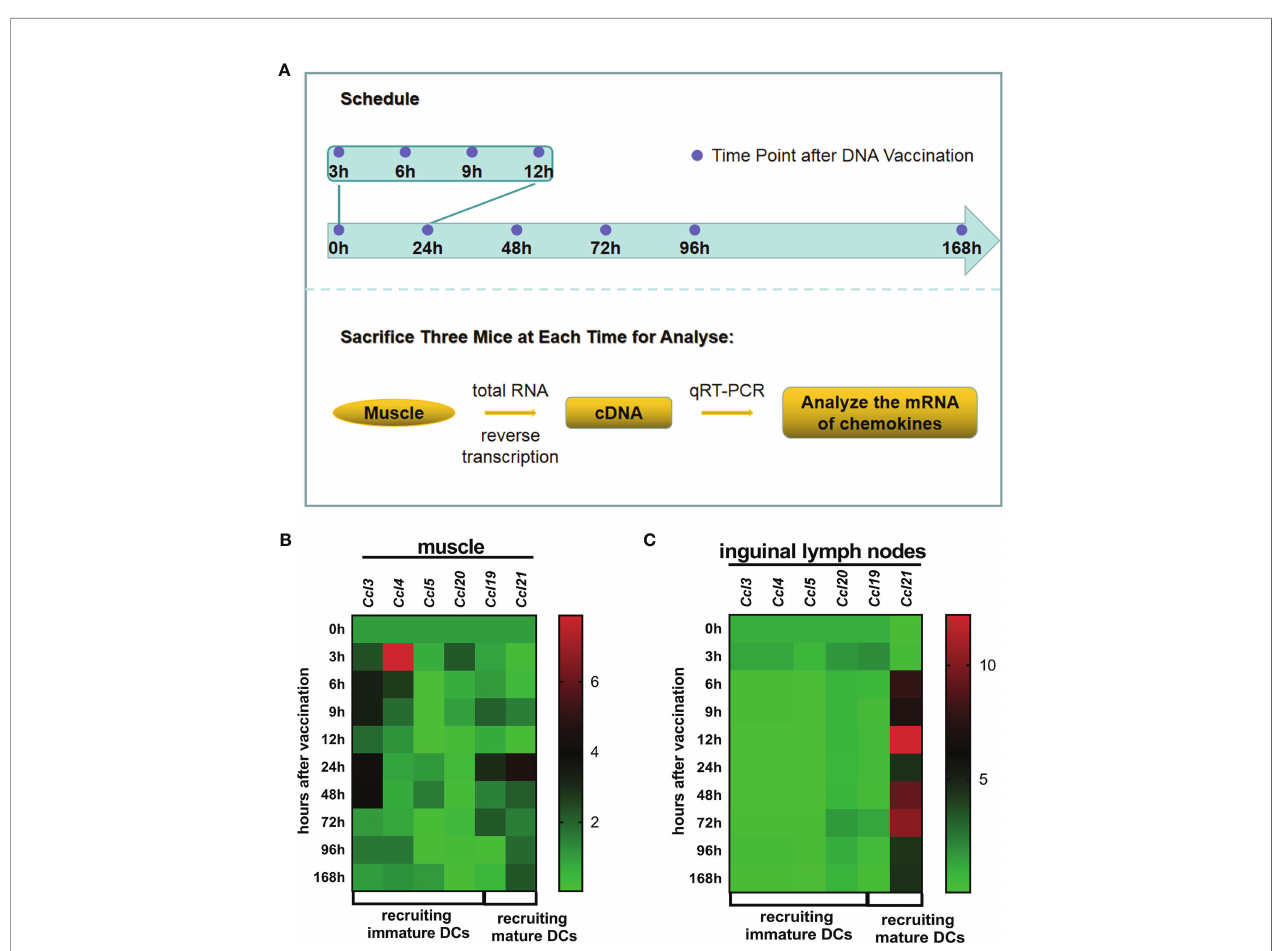
FIGURE 1 | Chemokines within muscle at the injection site and ipsilateral lymph nodes. (A) Administration and treatment schedule. Twenty-seven BALB/c mice were vaccinated with 100 m g CpDV-IL2-sPD1/MS DNA vaccine intramuscularly in hindlimb skeletal muscle. At 0, 3, 6, 9, 12, 48, 72, 96, and 120 h after the injection, three mice were sacri fi ced, and the muscle at the injection site and the inguinal lymph nodes were dissected. Total RNA was extracted and reverse- transcribed to cDNA. Quantitative real-time PCR (qRT-PCR) was conducted to analyze chemokine mRNA levels. The relative mRNA levels of chemokines recruiting immature dendritic cells (DCs) ( Ccl3 , Ccl4 , Ccl5 , and Ccl20 ) and those recruiting mature DCs ( Ccl19 and Ccl21 ) in muscle at the injection site (B) and ipsilateral lymph nodes (C)